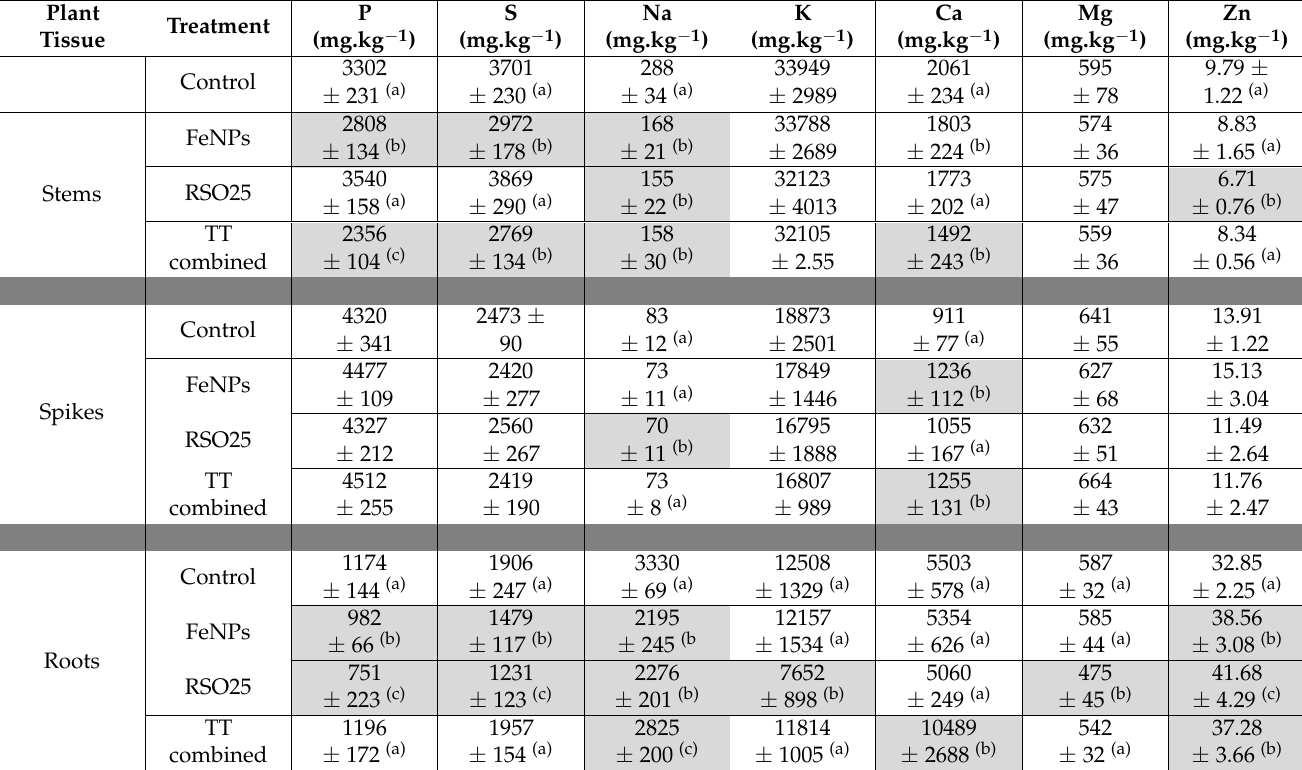
Table 3. Content of nutrients in plant tissues in mg.kg − 1 . Data are means ± SD of two independent determinations corresponding to the mix of six plants each. Different letters indicate means that are significantly different from each other in each specific tissue (LSD test, p < 0.05). Cells in gray indicate significant differences regarding the